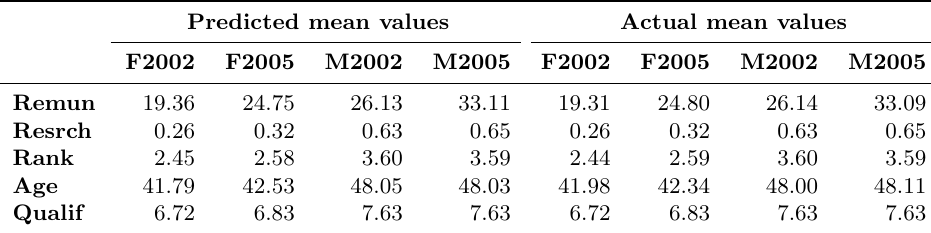
Table 2: Predictions obtained from CVA biplot versus true